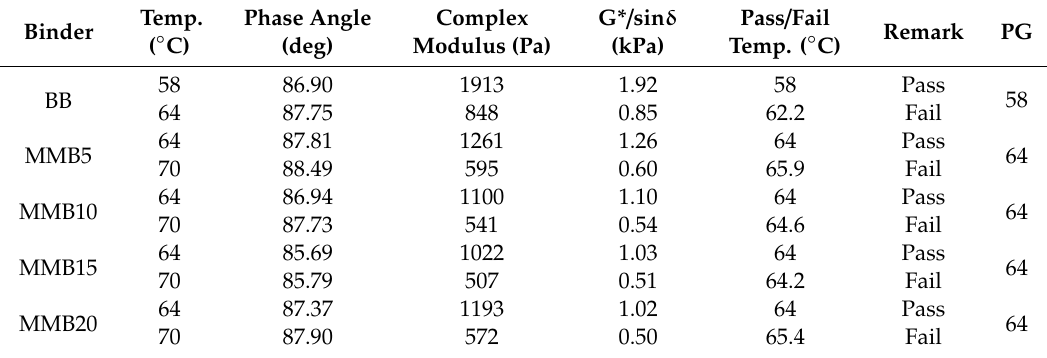
Table 8. Performance grade determination test result for the un-aged binders. Temp. Binder